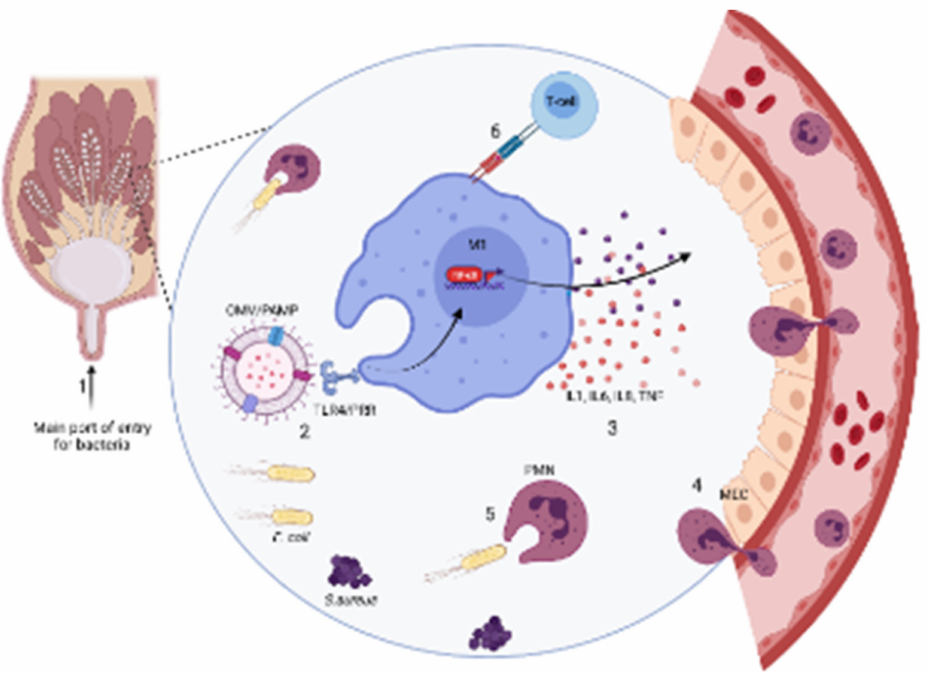
Figure 1. Schematic presentation of mastitis pathogenesis. Typically, (1) once bacteria invade the teat end and ascend into the teat canal and alveoli, a local immune reaction starts; (2) bacterial by products, such as lipopolysaccharide (LPS) or outer membrane vesicle (OMV) of Gram-negative pathogens act as pathogen-associated molecular pattern (PAMP), which is recognized by pathogen recognition receptors (PRR), specifically Toll-like receptor 4 (TLR4), on macrophage type 1 (M1). After this contact, (3) humoral elements, such as cytokines (IL1, IL6, and TNF) and chemokines [interleukin(IL)-8] are released that alert other white blood cells, mainly polymorphonuclear (PMN) leuckocytes in the systemic circulation and trigger the release of acute phase proteins; (4) Once PMN have entered in the infected area, through mammary epithelial cells (MEC), (5) they engulf and kill bacteria through phagoctysis. If this inflammation is persistent, (6) then adaptive immunity is activated via the interaction of macrophages with lymphocytes, like T-regulatory cells.